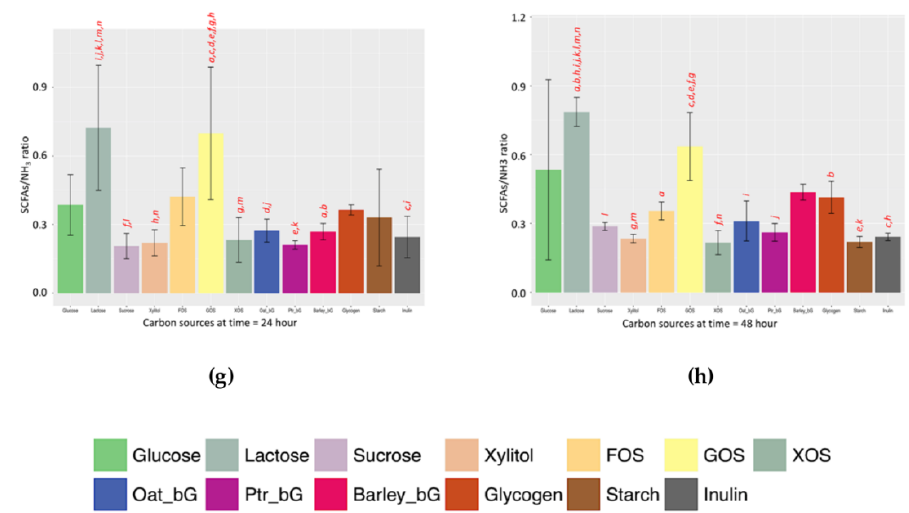
Figure 4. Total short-chain fatty acids (mM), dissolved ammonia (mg/mL), and total probiotic population (CFUs) produced by fermentation against the 13 carbohydrates and the SCFAs/NH 3 ratio at 24 and 48 h. ( a ) Total short-chain fatty acids (SCFAs) at time = 24 h; ( b ) total short-chain fatty acids at time = 48 h; ( c ) total ammonia concentration (NH 3 ) at time = 24 h; ( d ) total ammonia concentration at time = 48 h; ( e ) total probiotic population at time = 24 h; ( f ) total probiotic population at time = 48 h, and commensal bifidobacteria are enumerated as total probiotics; ( g ) SCFAs/NH 3 ratio at time = 24 h; ( h ) SCFAs/NH 3 ratio at time = 48 h. ANOVA with Tukey HSD posthoc adjustment (CI = 0.95) was used, paired-letters represented p -value < 0.05; “ ns ” denoted pairs with differences that are “ non- significant ” while all other pairs are statically significant to avoid over-crowded superscripts.